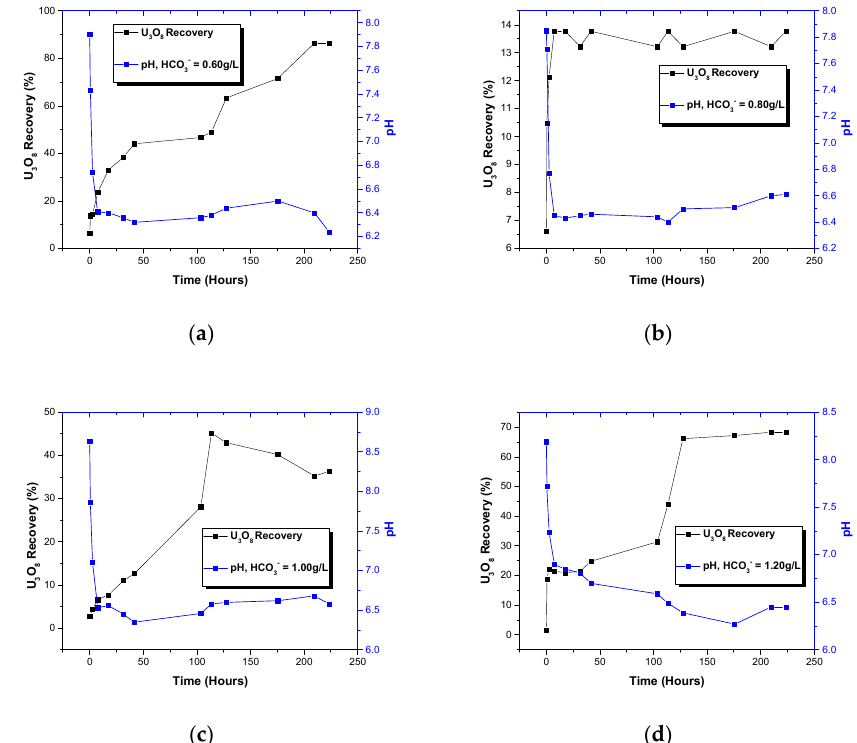
Figure 9. Trend of U 3 O 8 recovery and pH in leaching solution with different HCO 3 − concentrations: ( a ) 0.60g/L; ( b ) 0.80g/L; ( c ) 1.00g/L; ( d ) 1.20g/L). ( a ) 0.60 g / L; ( b ) 0.80 g / L; ( c ) 1.00 g / L; ( d ) 1.20 g /